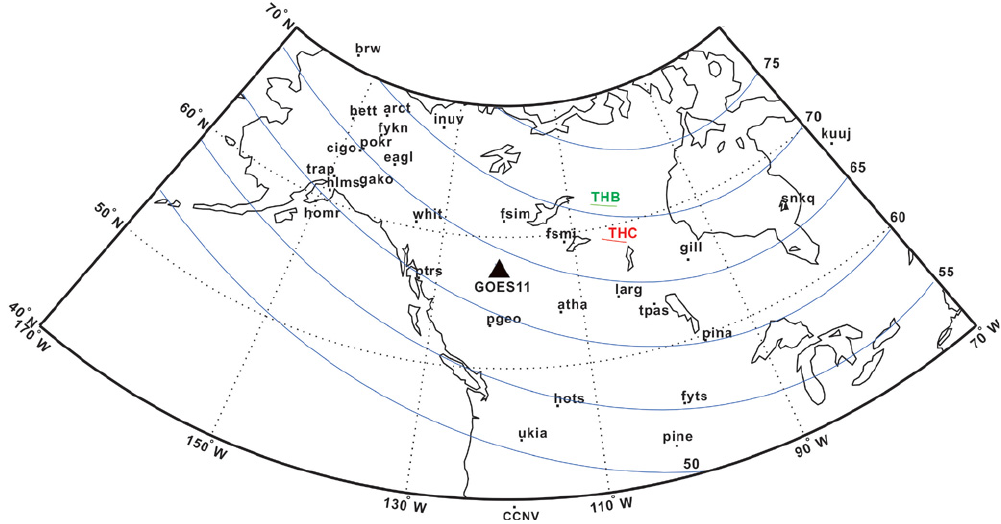
Fig. 1a. Foot point location of THEMIS B, THEMIS C, and GOES 11, and selected ground-based magnetic observatories for THEMIS mission and Alaska-chain observatories. The solid blue line represents the AAGCM latitude.